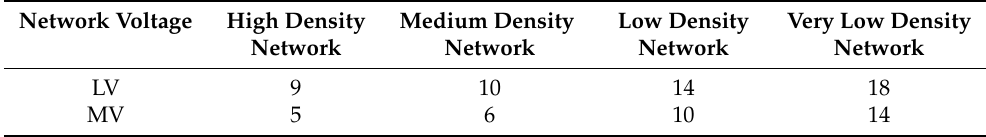
Table 4. Limits expressed in hours for the TIC indicator in Chile during the year 2020.